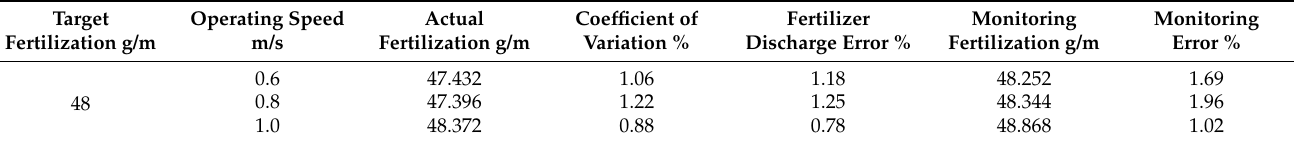
Figure 17. Fertilizer discharge accuracy test under different vehicle speeds. Table 8. Fertilizer discharge accuracy test of variable-rate fertilization system at different